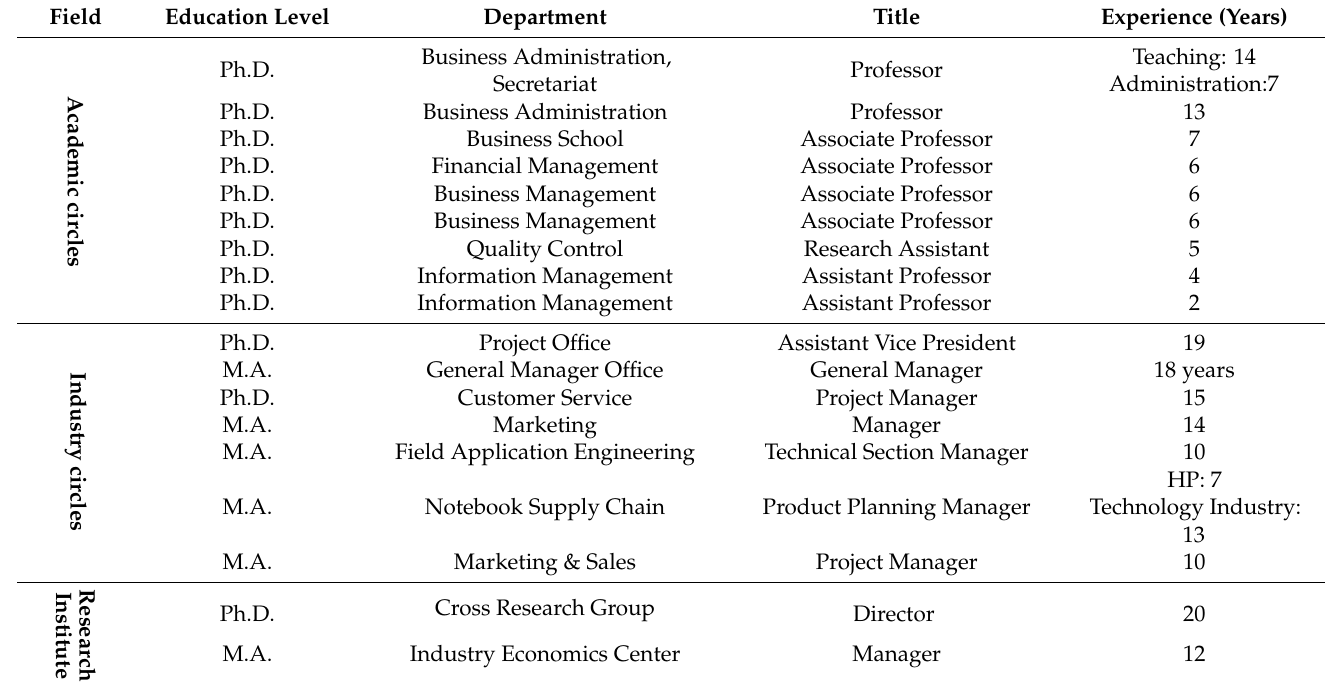
Table 1. Backgrounds of professions.